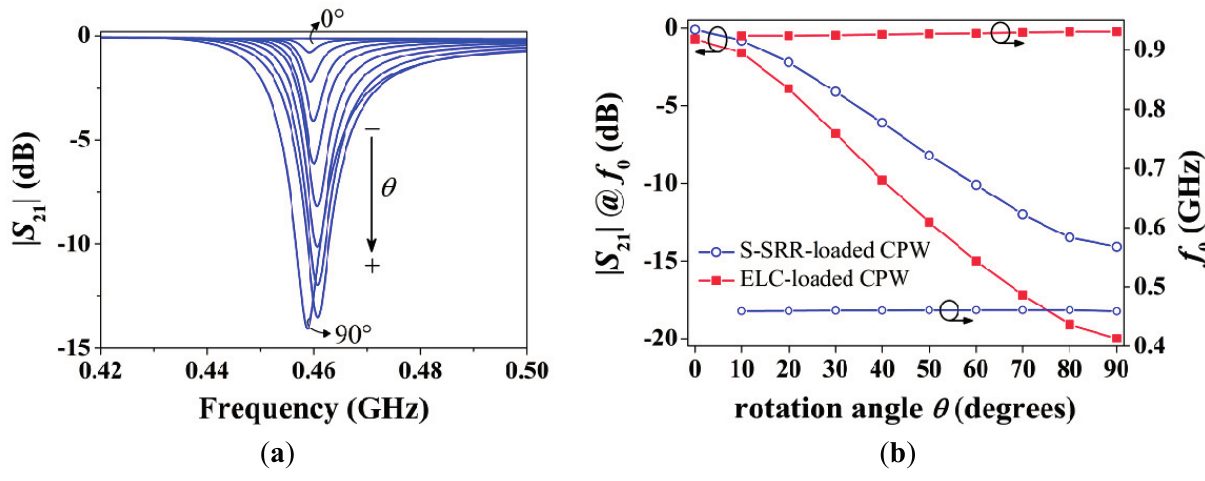
Figure 12. Simulated characteristics of the structures in Figure 11. ( a ) Transmission coefficient magnitude for the S-SRR-loaded CPW; and ( b ) transfer functions as sensors for different discrete